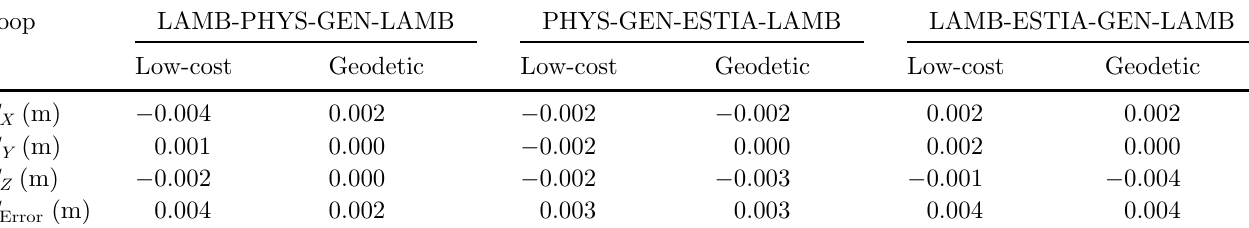
Table 6. Loop closure errors.